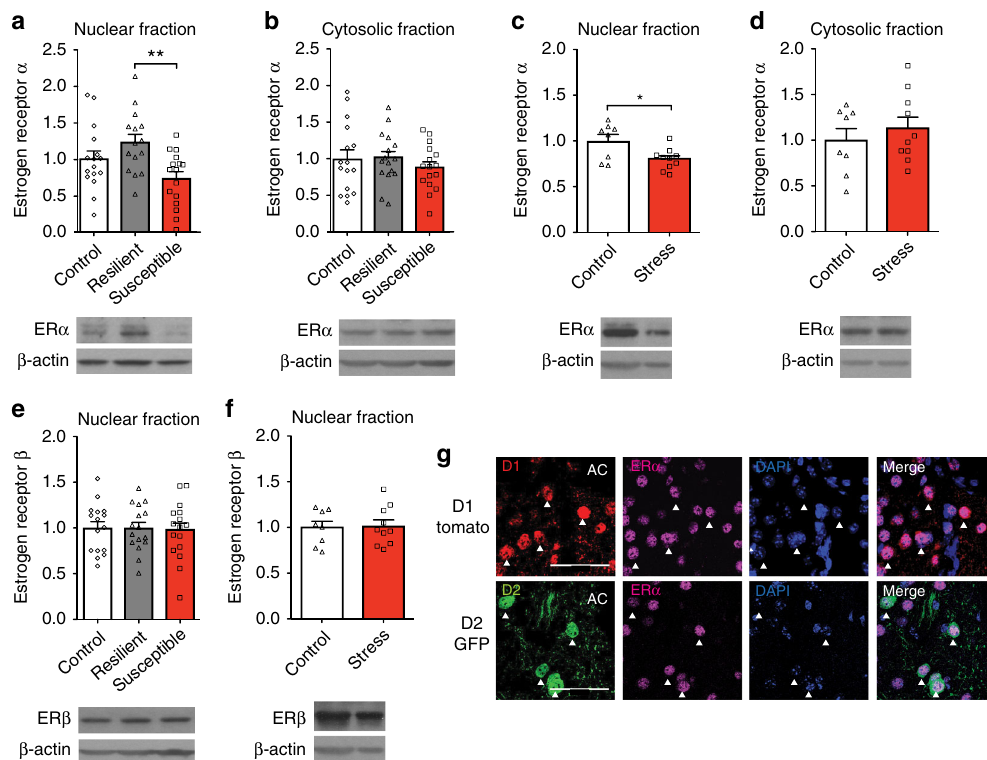
Fig. 2 Stress regulation of ER α in the NAc of male and female mice. a , b In male mice, NAc ER α protein expression is increased in the nuclear ( F (2,44) = 5.58, P < 0.007; n = 16,15,16) but not cytosolic ( F (2,44) = 0.56, P < 0.575; n = 16) fractions of resilient ( P < 0.01) mice after CSDS. c , d In female mice, NAc ER α protein levels are signi fi cantly decreased in the nuclear ( t (16) = 2.67, P < 0.017; n = 8,10) but not cytosolic ( t (16) = 0.76, P < 0.456; n = 8,10) fractions after CVS. e , f ER β protein expression in the NAc nuclear fraction is not regulated by stress in males ( F (2,45) = 0.05, P < 0.954; n = 16) or females ( t (16) = 0.16, P < 0.874; n = 8,10). g ER α expression is enriched in the nucleus of both D1-expressing and D2-expressing medium spiny neurons in the NAc (AC = anterior commissure). Scale bars = 100 μ M. Data are represented as mean ± SEM. a , b , e One-way ANOVA. c , d Two-tailed t test. * P < 0.05 t test, ** P <